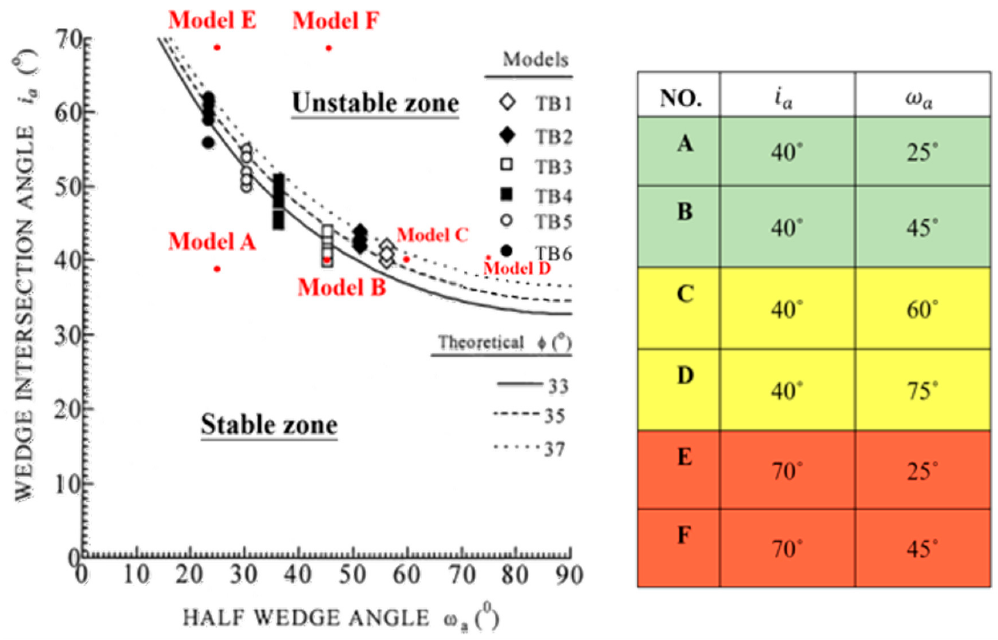
Figure 17. Comparison of tests with ω 1 ≠ω 2.